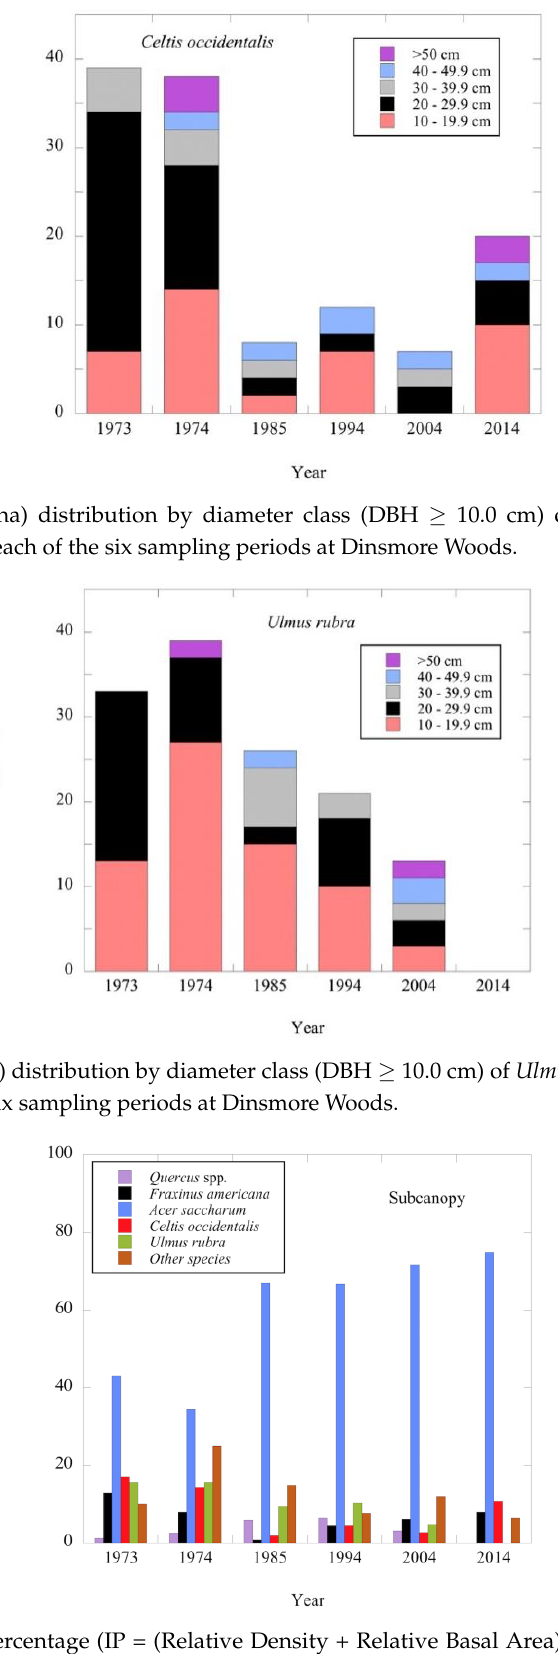
Figure 9. Importance percentage (IP = (Relative Density + Relative Basal Area)/2) for tree species recorded in the subcanopy stratum (DBH 10.0–29.9 cm) at Dinsmore Woods in the six sampling times.